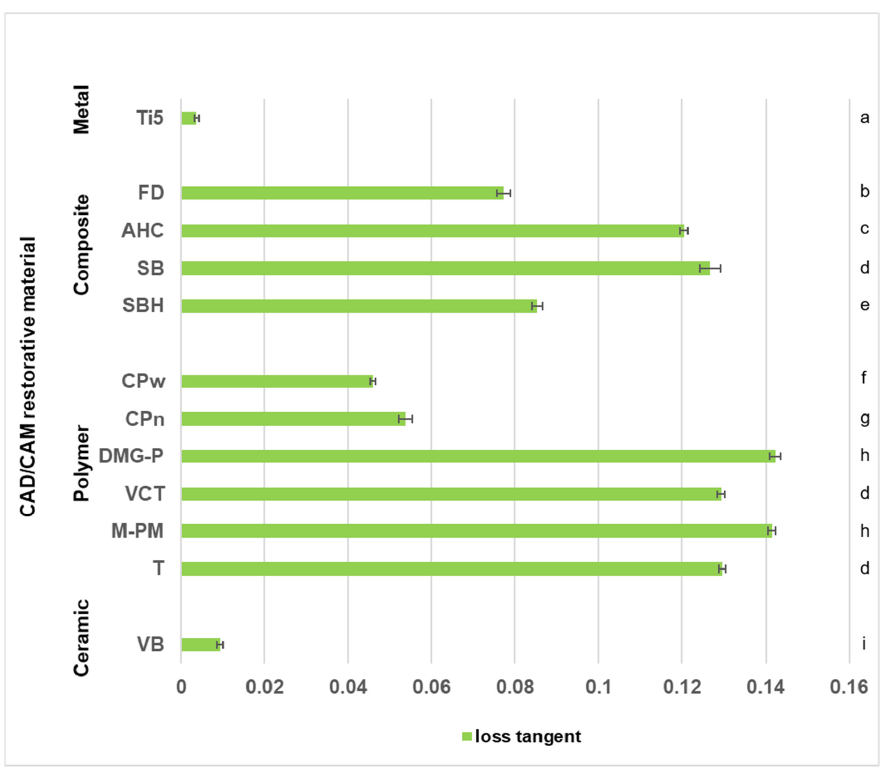
Figure 5. Loss tangent data determined via dynamic mechanical analysis. Identical lowercase letters on the right side denote no significant difference among CRMs ( p > 0.05). Parts of this data for Ti5, AHC, SB, SBH, VCT, M-PM,T, and VB were published in Journal of the Mechanical Behavior of Biomedical Materials, Th. Niem, S. Gonschorek, B. Wöstmann, Evaluation of the damping capacity of common CAD/CAM restorative materials, https://doi.org/10.1016/j.jmbbm.2021.104987, accessed: 17 January, 2022, Copyright Elsevier 2022. Selected and representative surface topographies to characterize the Leeb hardness indentation areas are displayed in Figure 6, while the respective indentation volumes and depths are summarized in Table 2. The deepest indentations were observed for Ti5 fol- lowed by the PEEK-based polymers CPn and CPw as well as the fiber-reinforced compo- site FD. In contrast to this ranking, no indentation or further surface alterations were de- tected for all the other polymer CRMs (DMG-P, M-PM, T, and VCT) (Table 2).